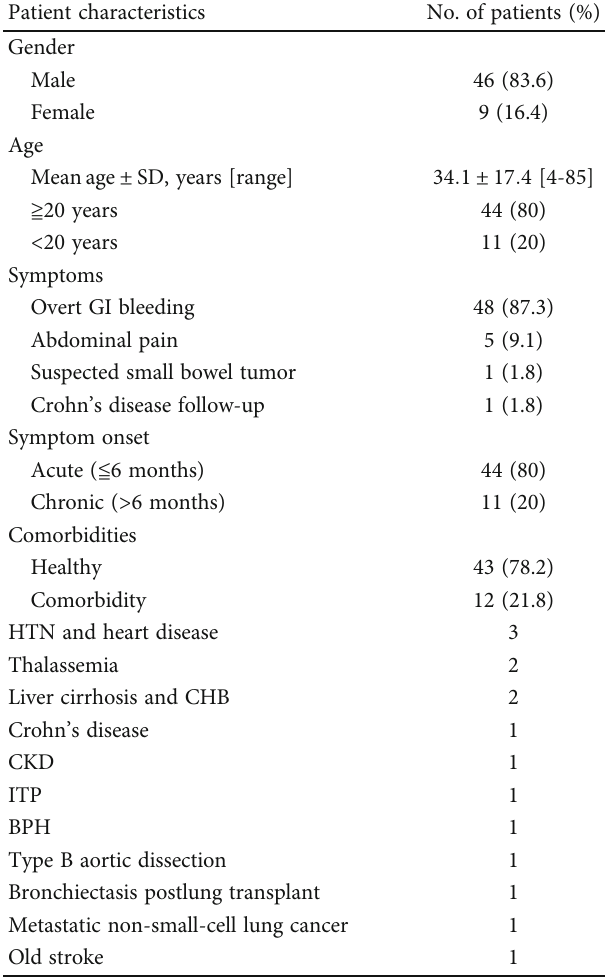
Table 1: Clinical characteristics of patients with Meckel ’ s diverticulum diagnosed by BAE ( n = 55